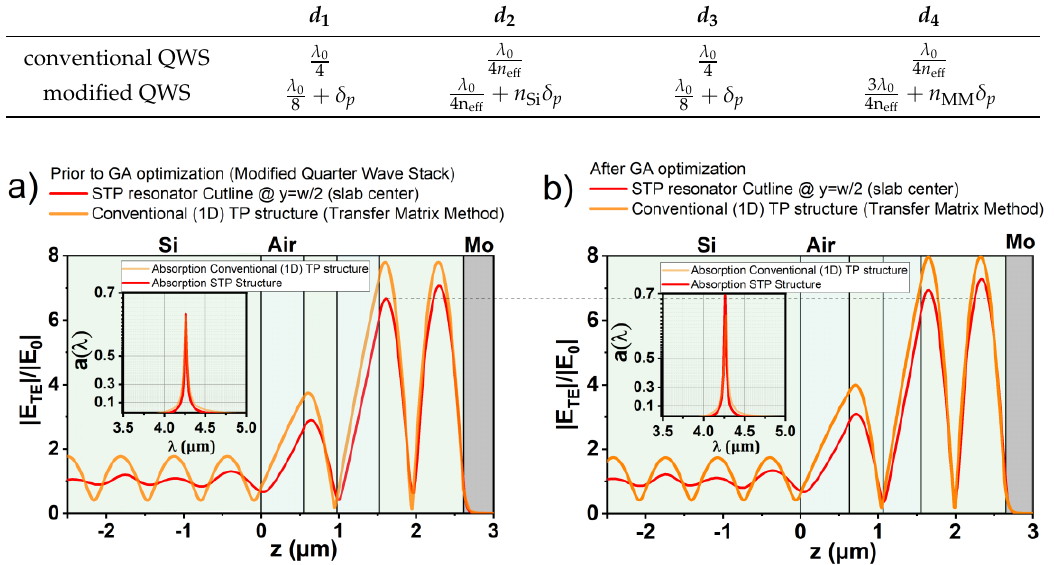
Figure 3. Comparison of relative field enhancement between the conventional 1D TP structure (orange solid line) and the STP structure (cross-section through the 0.9 µ m Si slab center, red solid line) for the modified quarter wave stack with Mo at λ 0 . ( b ) Analogous to panel ( a ) for the optimized configuration via the GA process. The insets show the corresponding spectral responses of the structures.